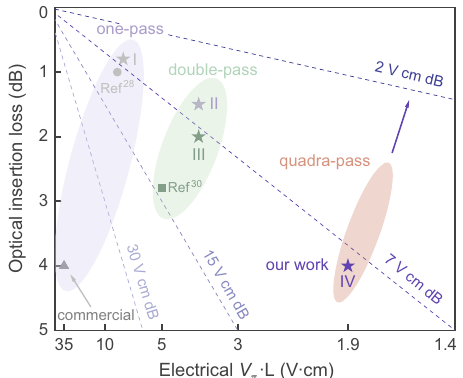
Fig. 5 Performance comparison of non-resonant electro-optic (EO) comb generators on lithium niobate (LN) platform. The comparison includes the on-chip optical insertion losses and radio-frequency (RF) phase-modulation V π ∙ L values. Star marks correspond to devices in this work, which operate along the line of 7 V ∙ cm ∙ dB, leading to a low RF V π ∙ L of 1.9 V ∙ cm at 25 GHz. The horizontal axis is plotted in inverse scale to better visualize the device modulation ef fi ciency, which is inversely proportional to the half- wave